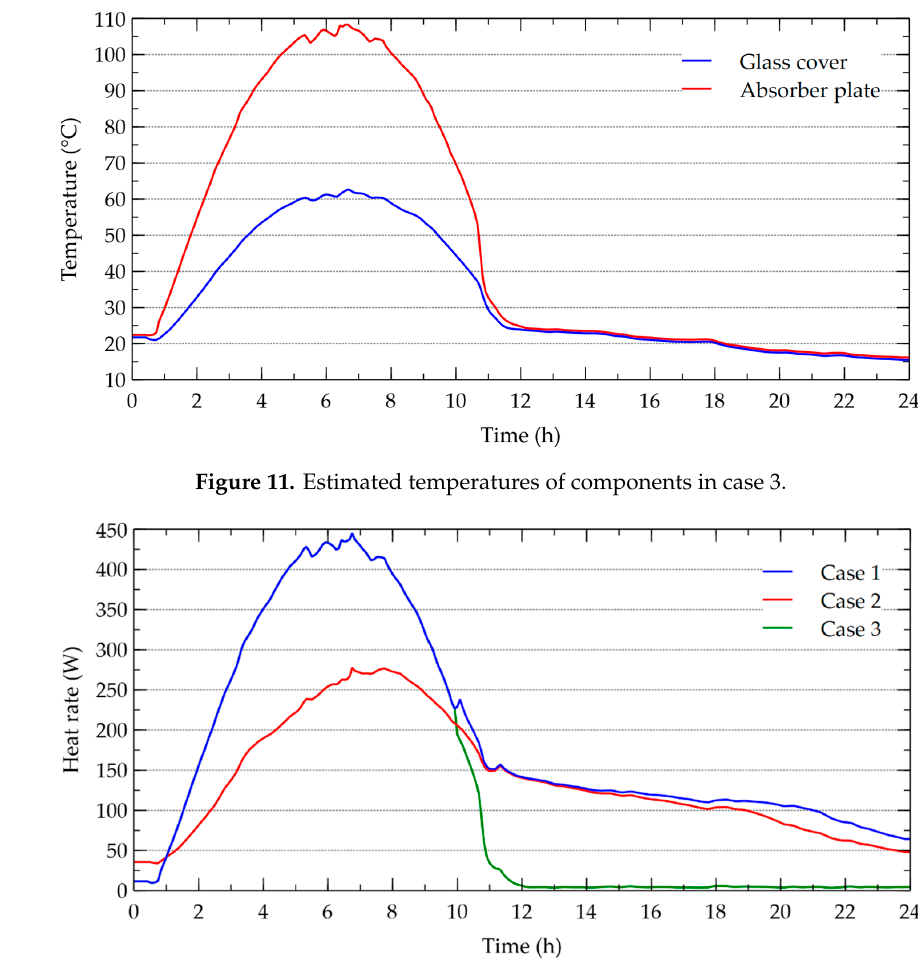
Figure 12. Estimated useful heat rate. Energies 2020 , 13 , x FOR PEER REVIEW